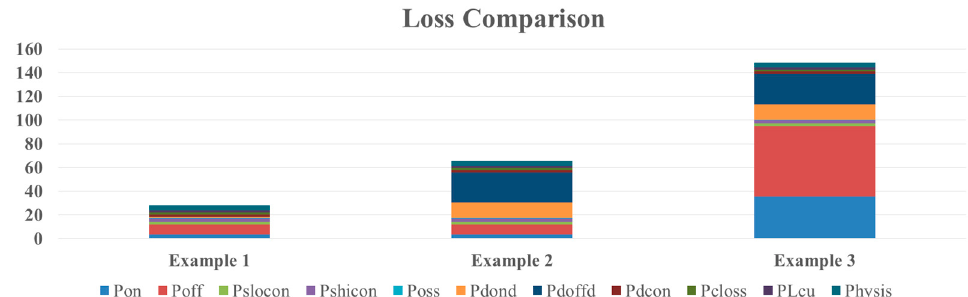
Figure 9. Loss comparison between calculation examples.